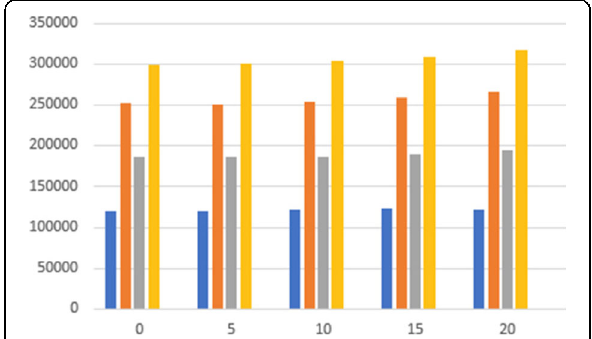
Fig. 1 (abstract A31). Count rate for BGO, GSO, LSO and LYSO crystals in monolithic detectors